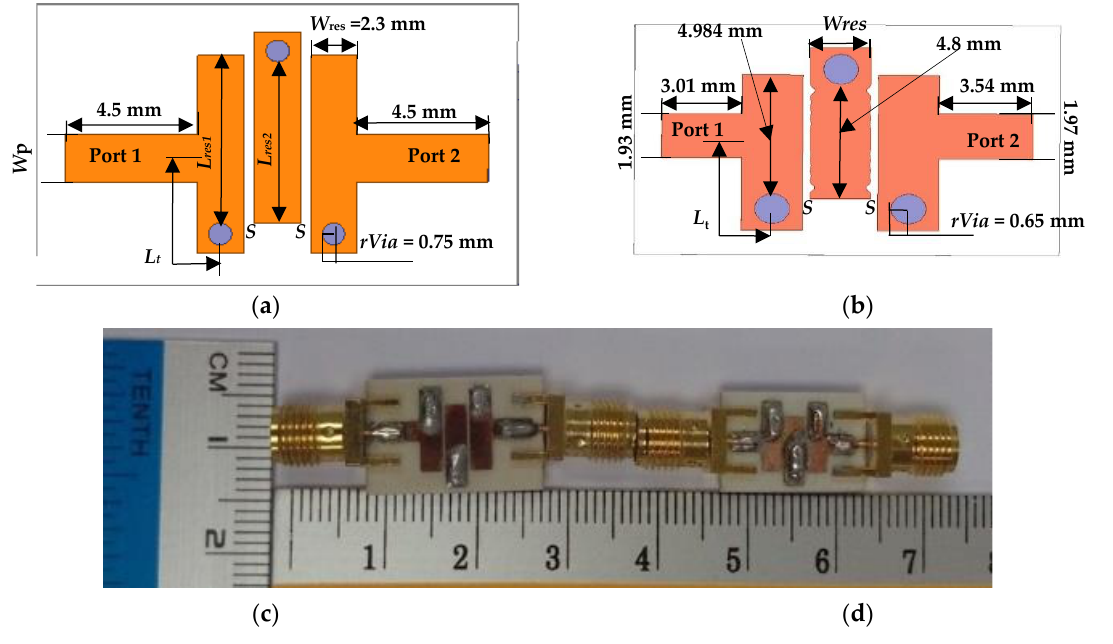
Figure 10. (a), (b) 2D configuration and (c), (d) photograph of the proposed (5.975 – 7.125 GHz) UTL Figure 10. ( a , b ) 2D configuration and ( c , d ) photograph of the proposed (5.975–7.125 GHz) UTL and and NTL IBPFs, respectively. NTL IBPFs,